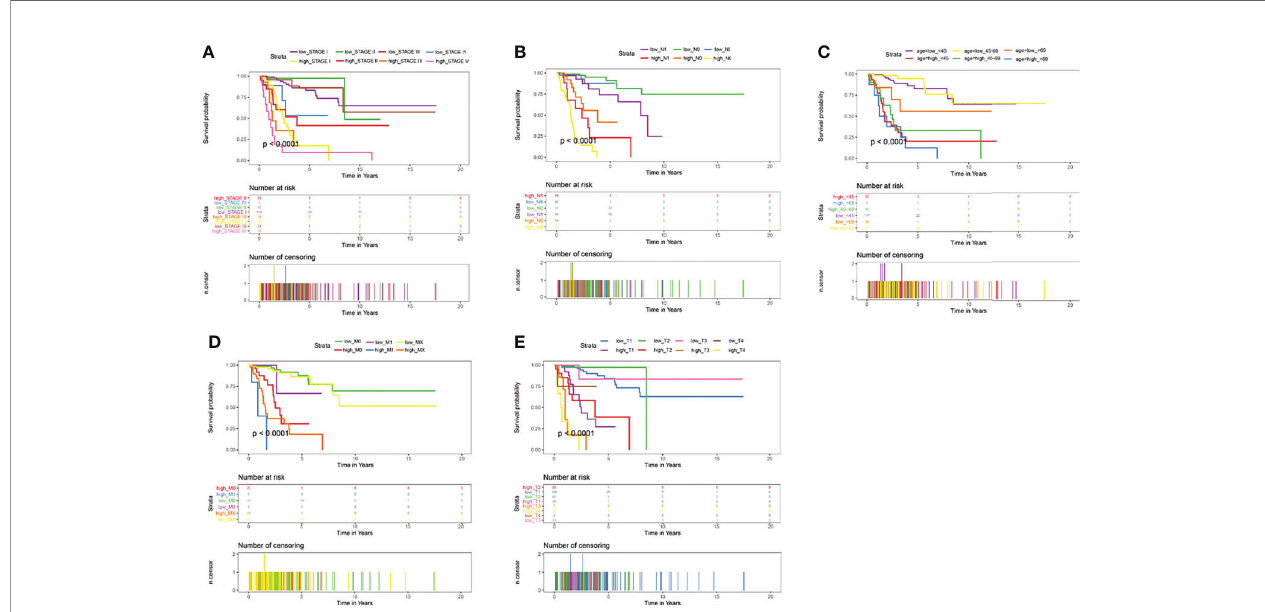
FIGURE 8 | Kaplan-Meier Curves of OS for this prognostic model. (A) age, (B) stage, (C) pathologic_T, (D) pathologic_N, (E) pathologic_M.